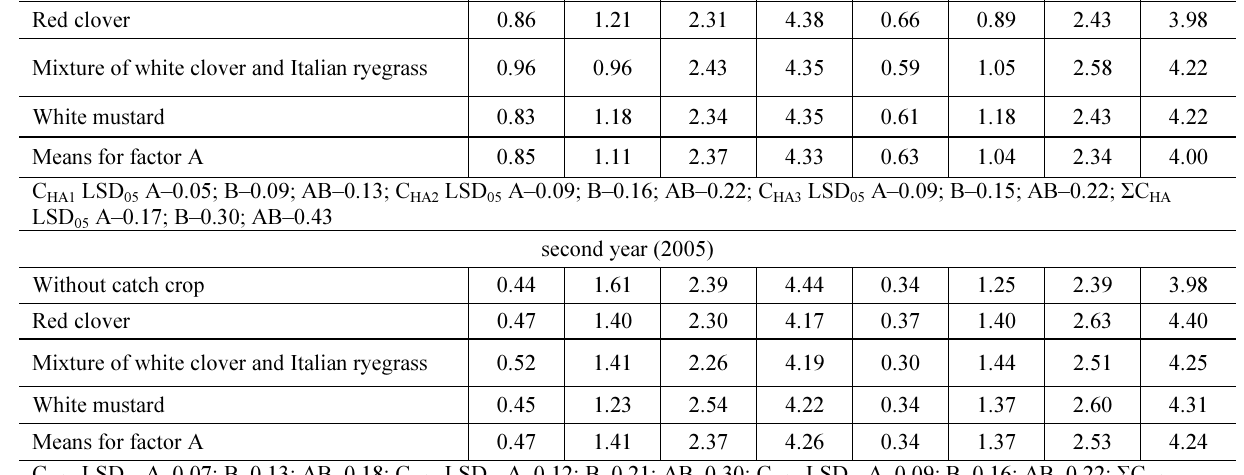
Table 2. Change of humic acids (C HA ) fractions (C g kg –1 of soil) in the soil (0–25 cm) after catch crop biomass and straw incorporation Before trial